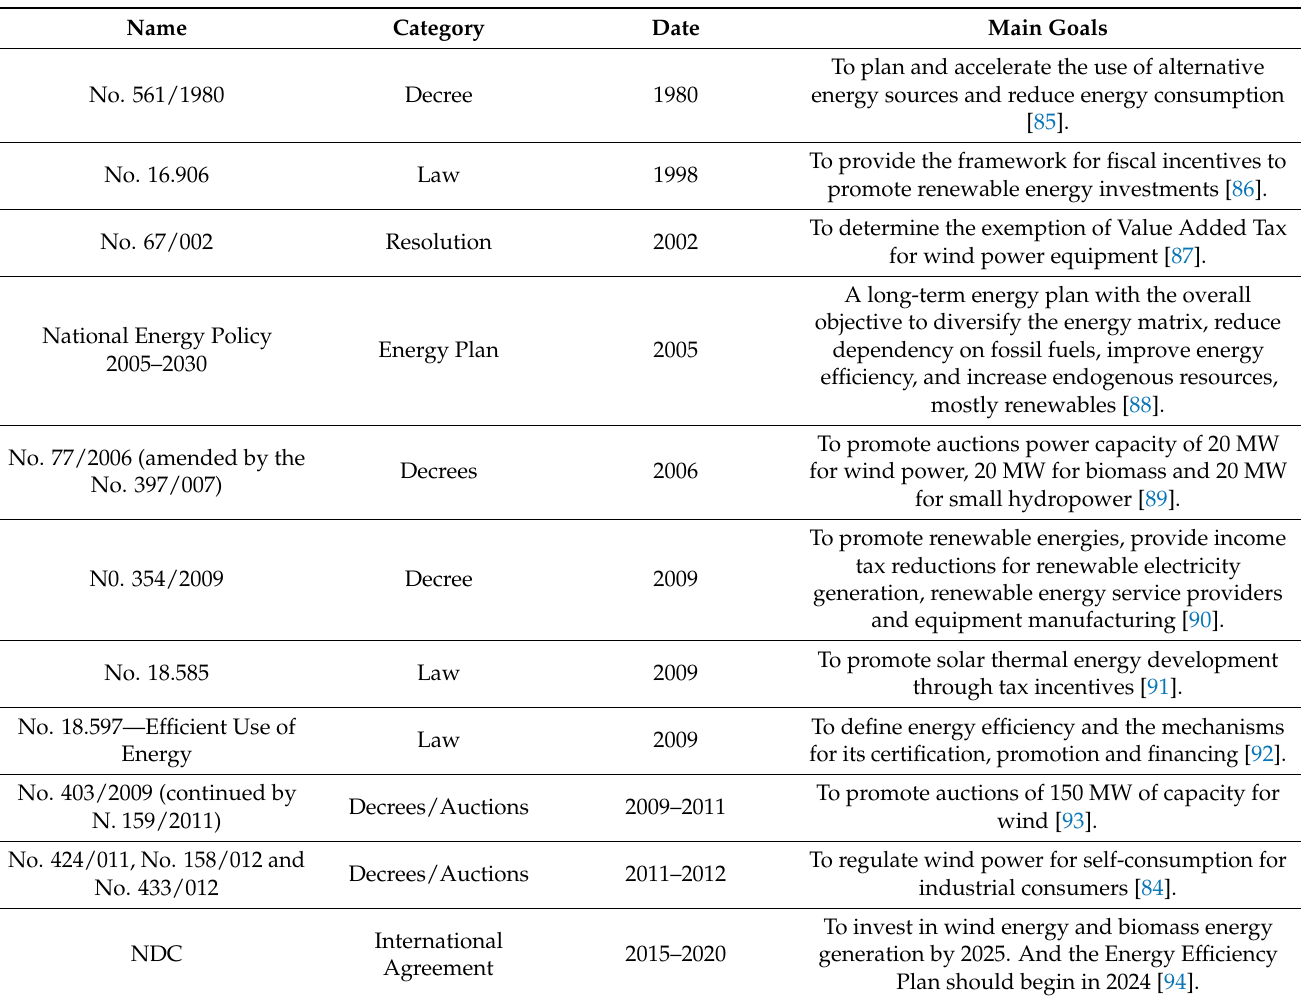
Table 5. Main government incentives for the entry of renewable energy into Uruguay’s electricity sector